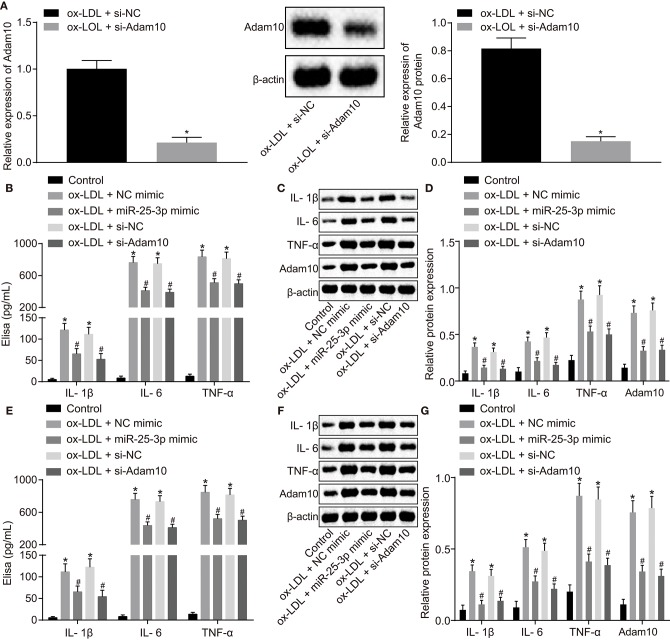
MiR-25-3p represses CVEC inflammation by regulating Adam10. (A) mRNA and protein expression of Adam10 in response to the co-treatment of ox-LDL + NC mimic, ox-LDL + miR-25-3p mimic, ox-LDL + si-NC or ox-LDL + si-Adam10, as determined by RT-qPCR and Western blot analysis. (B) Levels of IL-1β, IL-6, and TNF-α in response to the co-treatment of ox-LDL + NC mimic, ox-LDL + miR-25-3p mimic, ox-LDL + si-NC or ox-LDL + si-Adam10, as measured by ELISA. (C,D) Protein bands and levels of IL-1β, IL-6, and TNF-α in response to the co-treatment of ox-LDL + NC mimic, ox-LDL + miR-25-3p mimic, ox-LDL + si-NC or ox-LDL + si-Adam10, as determined by Western blot analysis. (E) Levels of IL-1β, IL-6, and TNF-α in response to the co-treatment of ox-LDL + PBS, ox-LDL + PLT-Exo, ox-LDL + si-NC or ox-LDL + si-Adam10, as measured by ELISA. (F,G) Protein bands and levels of IL-1β, IL-6, and TNF-α in response to the co-treatment of ox-LDL + PBS, ox-LDL + PLT-Exo, ox-LDL + si-NC or ox-LDL + si-Adam10, as determined by Western blot analysis. *p < 0.05 vs. the control group; #p < 0.05 vs. the ox-LDL + NC mimic (CVECs co-treated with ox-LDL + NC mimic), ox-LDL + si-NC (CVECs co-treated with ox-LDL + si-NC), or ox-LDL + PBS group (CVECs co-treated with ox-LDL + PBS). All data are measurement data and expressed as mean ± standard deviation; data among multiple groups were analyzed using one-way ANOVA. The experiment was repeated three times independently.